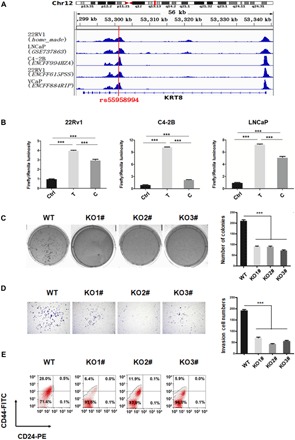
The chromatin locus containing rs55958994 is a functional enhancer in PCa cells.(A) H3K27ac ChIP-seq data from PCa cell lines are shown. (B) Luciferase reporter activity in 22Rv1, C4-2B, and LNCaP cells transfected with luciferase reporters. Ctrl, luciferase reporter without the inserted enhancer; C, luciferase reporter with the rs55958994-associated enhancer region with the nonrisk allele “(C)”; T, luciferase reporter with the rs55958994-associated enhancer region with the risk allele (T). Data represent means ± SEM of three independent experiments. ***P < 0.001. (C) Soft agar colony formation assays comparing wild-type (WT) 22Rv1 cells and three enhancer-deleted cell lines [knockouts (KOs) 1 to 3]. Quantification is at right. Data represent means ± SEM of three independent experiments. ***P < 0.001. (D) Transwell assays in WT 22Rv1 cells and three enhancer-deleted cell lines (KOs 1 to 3). Cells that had migrated to lower chambers were stained with 0.1% crystal violet. Quantification is at right. Data represent means ± SEM of three independent experiments. ***P < 0.001. (E) Fluorescence-activated cell sorting (FACS) analysis of the cell surface markers CD44 and CD24 in WT 22Rv1 cells and three enhancer-deleted cell lines (KOs 1 to 3). FITC, fluorescein isothiocyanate; PE, phycoerythrin.